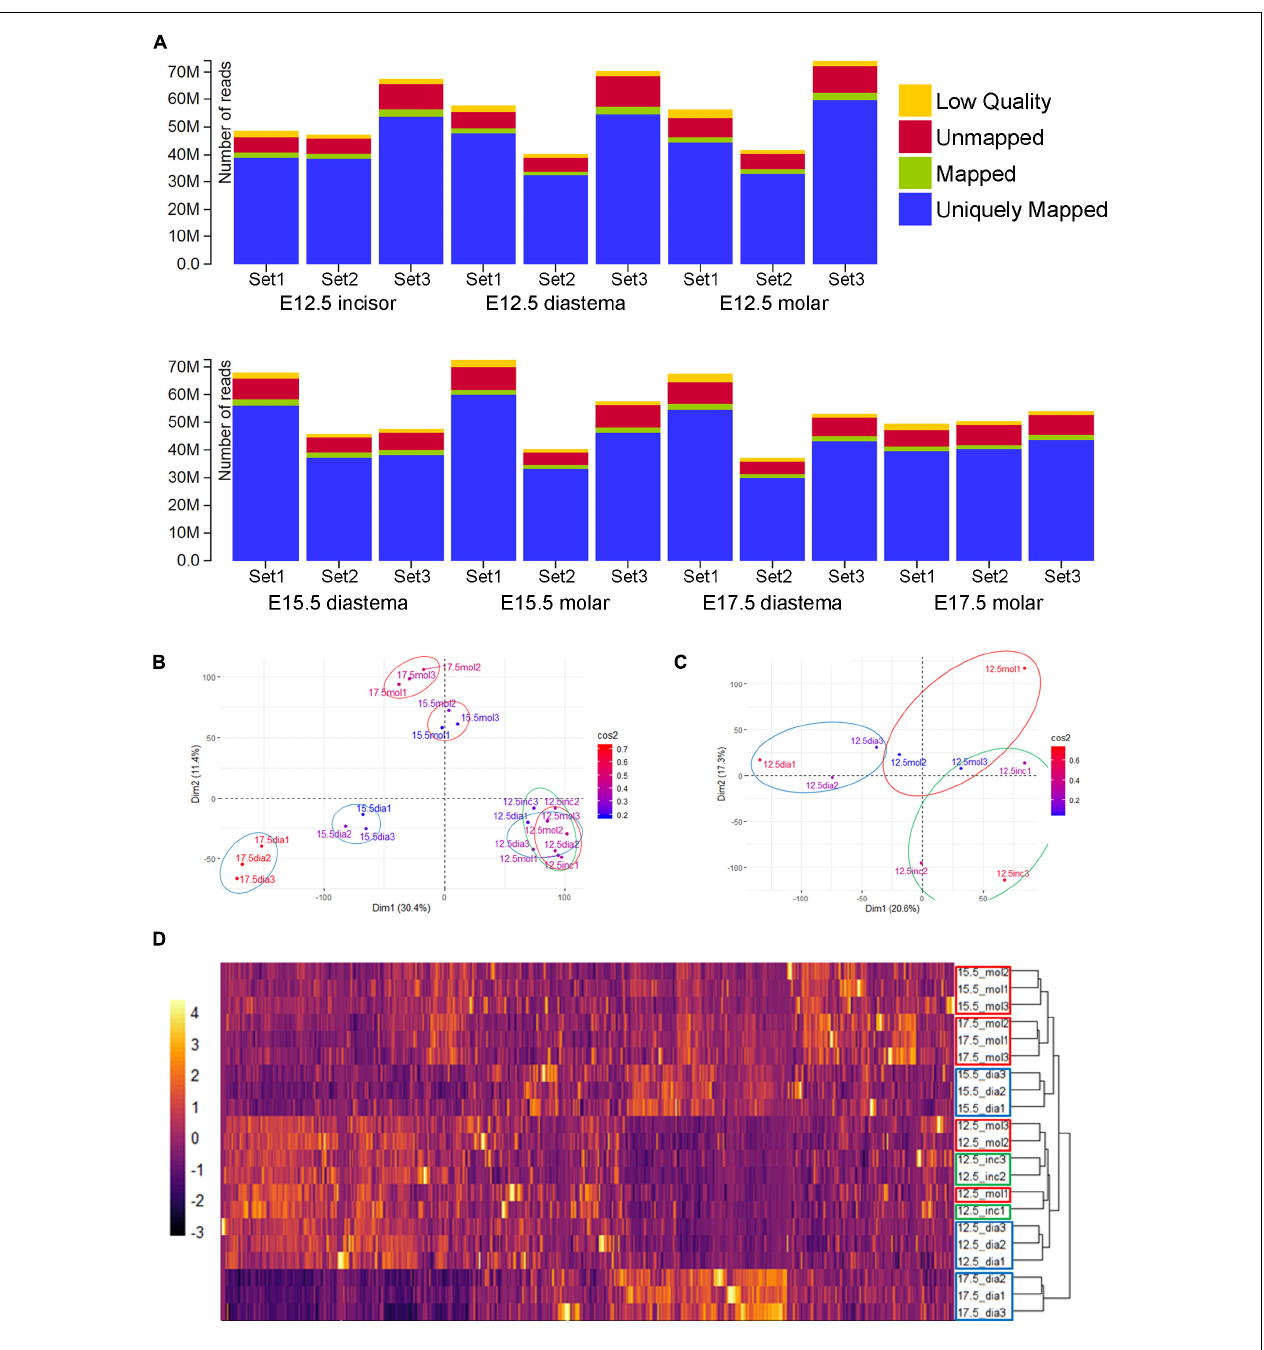
FIGURE 2 | RNA-Seq data alignment and clustering. (A) Alignment results of 21 samples. More than 80% of total reads were uniquely mapped (the read mapped to exactly one location within the reference genome). (B) Principal component analysis (PCA) result of normalized gene expression (FPKM). E15.5 and E17.5 samples clustered by PC1 and PC2. E12.5 groups seem not separated well. (C) PCA result of E12.5 samples. Diastemas were separated from odontogenic regions by the PC1 axis. Incisors and molars were separated by the PC2 axis. (D) Heatmap of expression and dendrogram of 21 samples. E12.5 incisors and molar show a similar RNA expression. At E15.5 and E17.5, molars and diastemas had clustered with each other. Particularly, E17.5 diastema showed the most different pattern from other experimental groups.